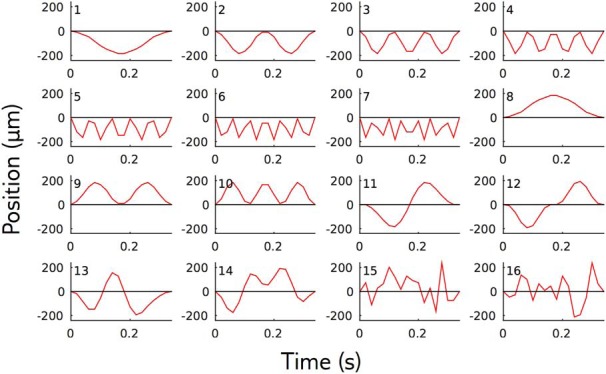
Perturbations shapes. We used the same 16 perturbation shapes for the two reference stimuli. The first 12 perturbation shapes were combinations of two Fourier components, and the last four ones were random combinations of them: fk(t)=cos(2πkt/T) and gk(t)=(1/k) * sin(2πt * k/T), with T the duration of the perturbation and t = 0 the beginning of the perturbation. The first perturbations j = 1…7 were Sj=fj−1. For j = 8,…,10, they were the opposite of the three first ones: Sj=−Sj−7. For j = 11, 12 we used Sj=gj−10+1−g1. Perturbations 13 and 14 were random combinations of perturbations 1, 2, 3, 11, and 12, constrained to be orthogonal. Perturbations 15 and 16 were random combinations of fj for j ∈ [1,8] and gk for k ∈ [1,7], allowing higher frequencies than perturbation directions 13 and 14. Perturbation direction 15 and 16 were also constrained to be orthogonal. The largest amplitude for each perturbation we presented was 115 µm. An exception was made for perturbations 15 and 16 applied to the second reference trajectory, as for this amplitude they had a discrimination probability below 70%. They were thus increased by a factor 1.5. The largest amplitude for each perturbation was repeated at least 93 times, with the exception of perturbation 15 (32 times) and 16 (40 times) on the second reference trajectory.